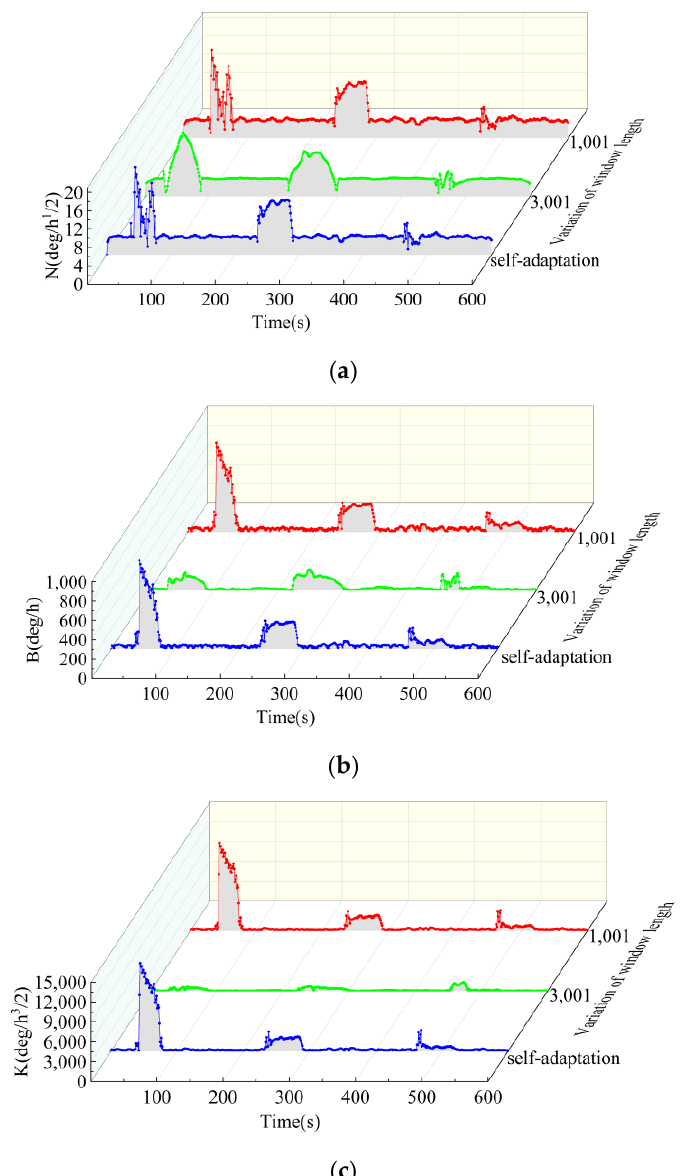
Figure 7. DAVAR analysis of noise coefficient under different window lengths. ( a ) Change curve of ARW coefficient N under different window lengths; ( b ) Change curve of BI coefficient B under different window lengths; ( c ) Change curve of RRW coefficient K under different window lengths.